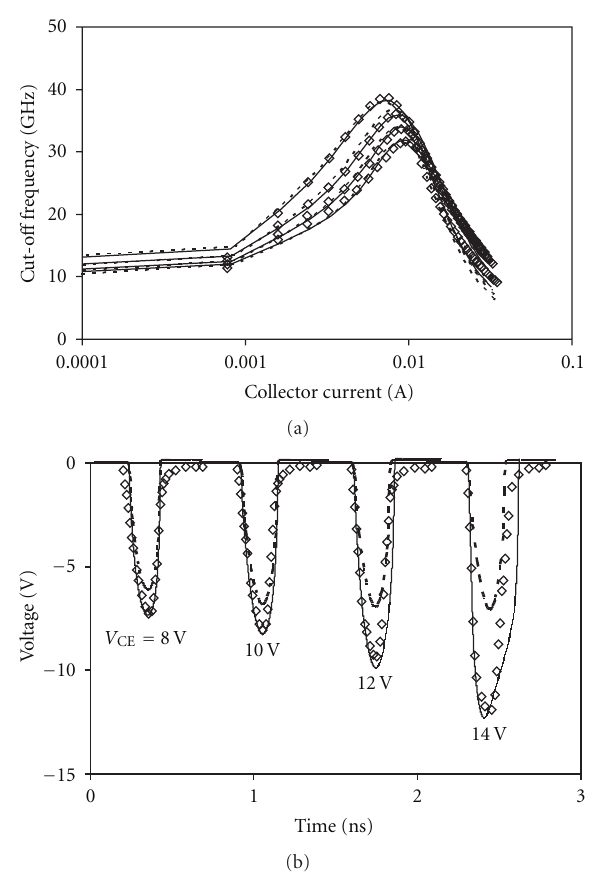
Figure 3: Measured (symbol) (a) cuto ff frequency f T and (b) impulse response of a typical HBT versus that simulated by using the Agilent (dashed curve) and modified (solid curve) HBT model. In (a), V CE = 1, 2, 3, and 4V top down. In (b), the input pulse width and amplitude are 0.2 nanosecond and 1.45 V, respectively. V BE = 0. Artificial delays between impulses are added for